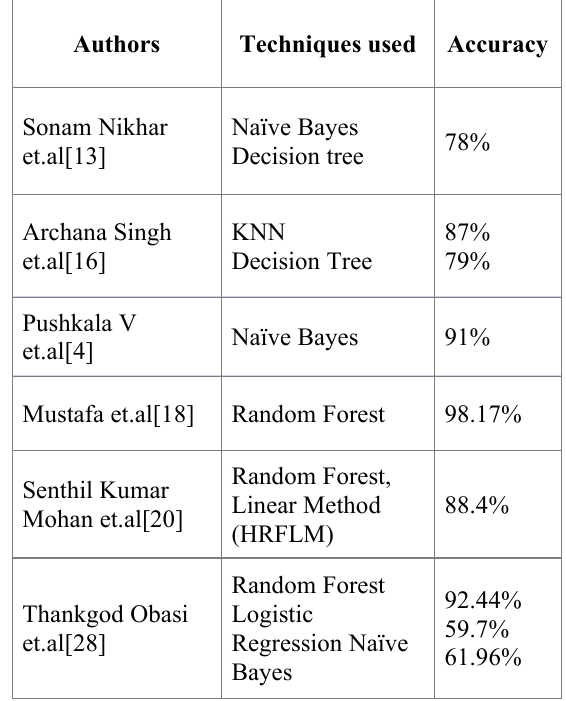
Table 2. Performance Analysis Chart based on the Reviewed